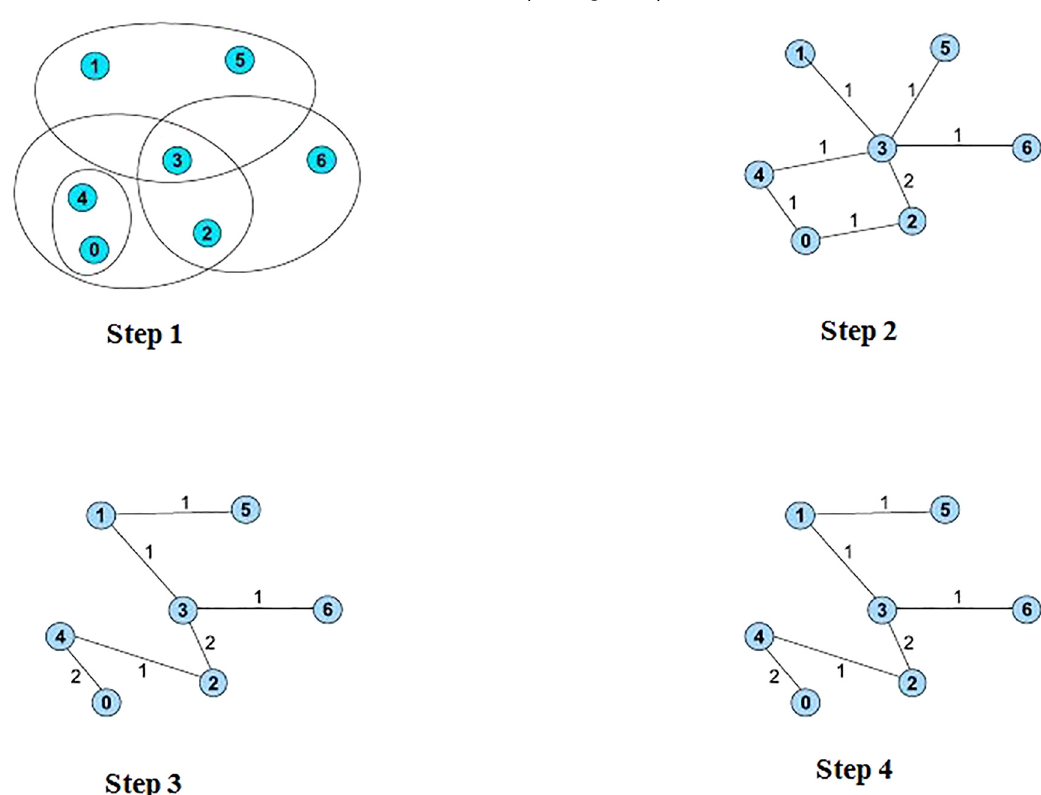
Figure 5: A running example of the reordering algorithm